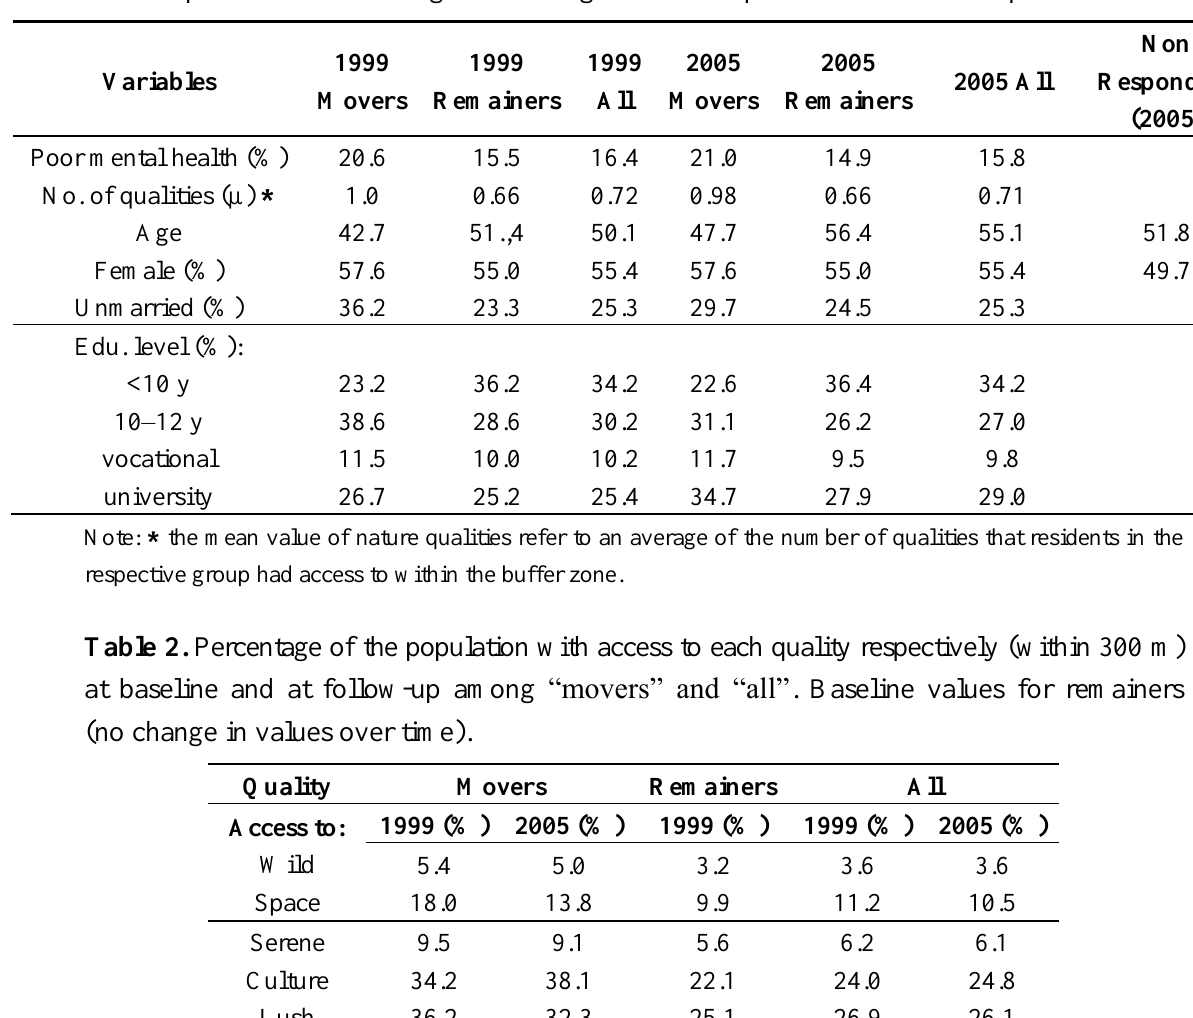
Table 1. Mental health, demographics, and amount of nature qualities in the three groups: (1) “movers” (n = 1419); (2) “remainers” (n = 7811); and (3) “all” (n = 9230) at baseline and follow-up. Available data on gender and age for non-responders 2005 are also presented.